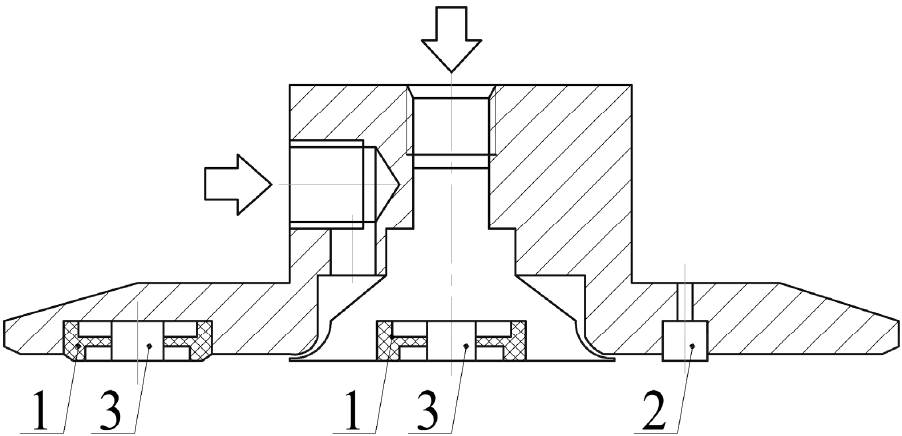
Figure 1. Design of Festo Bernoulli gripping device [43]: the ring-shaped spacers (1) are made from polyoxymethylene and the knobs ((2) and (3)) are made from nitrile butadiene rubber.